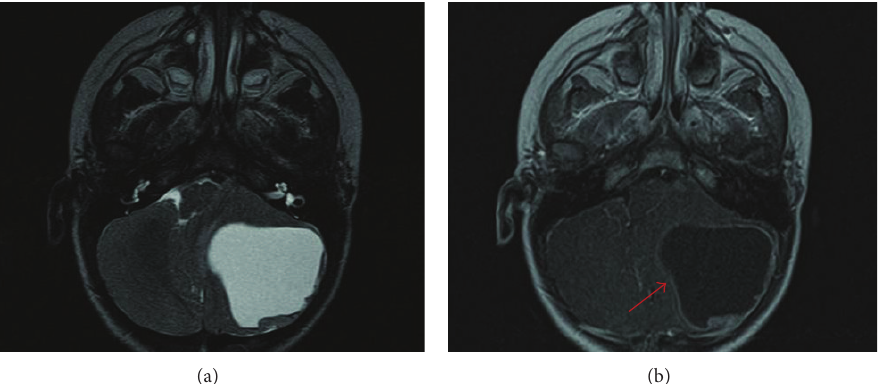
Figure 5: Axial T2 (a) and T1-contrast-enhanced (b) MR images of brain. There is a 5.6 × 5.1 cm largely cystic mass with peripheral nodular enhancement (arrow in (b)) involving the left cerebellar hemisphere. There is mass effect with compression of the 4th ventricle and effacement of the left premedullary